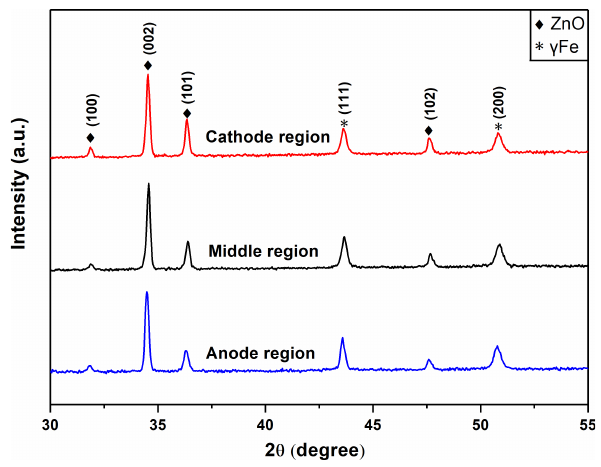
Figure 2: Characteristics of three locations ZnO nanoarrays on SSS.